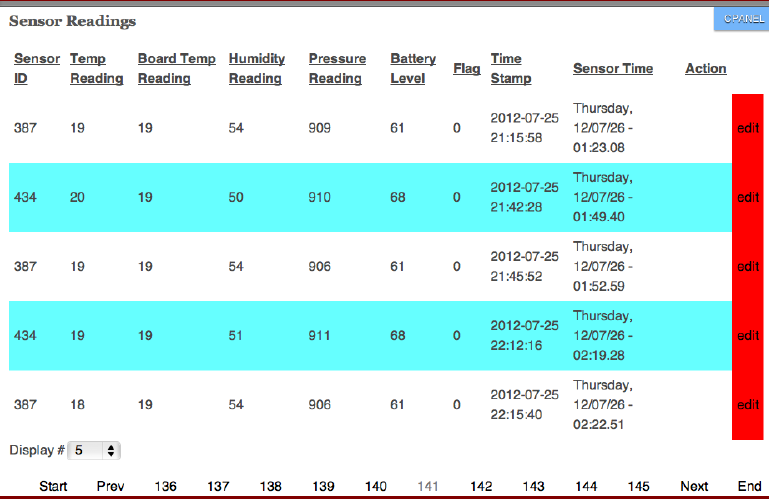
Figure 7. Sensor board monitoring